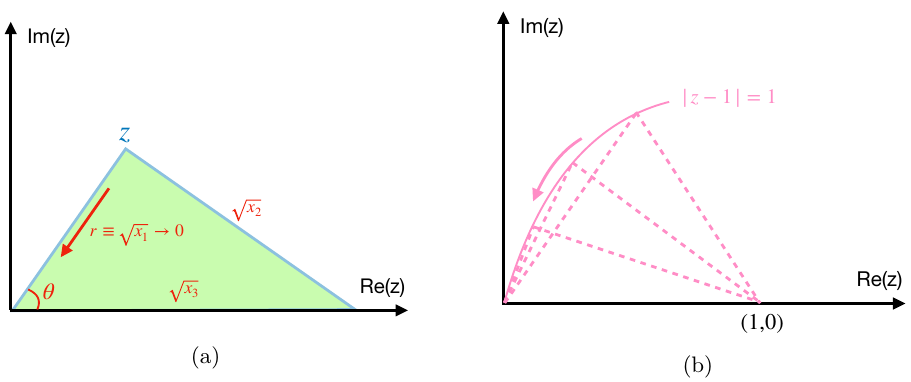
√ √ √ x 1 , x 2 and x 3 under the 0 , x . 1 → 2 , 3 ∼ η